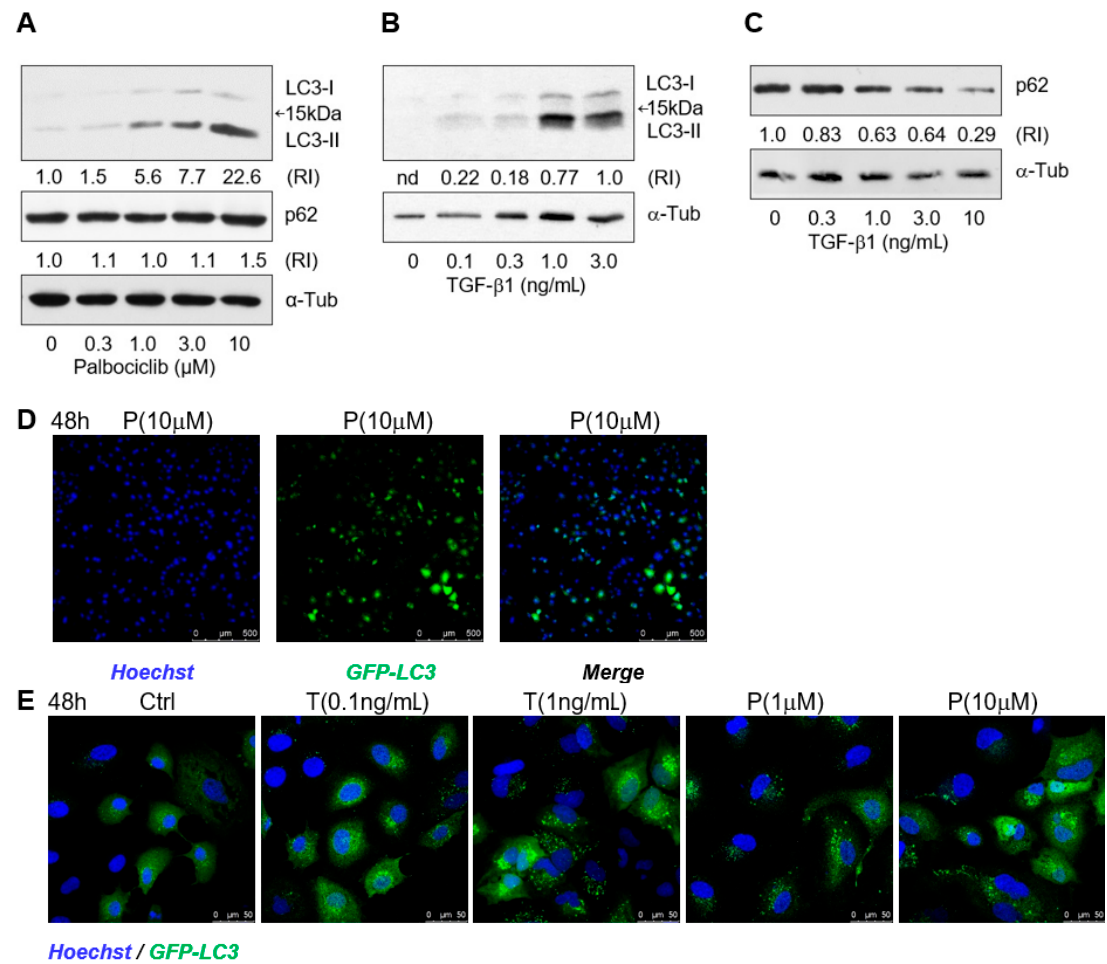
Figure 4. TGF- β 1 and palbociclib activate biogenesis of autophagosome in hepatoma cells. ( A ) Western blots for LC3-I, LC3-II, and p62 in Huh7-luc/neo cells treated with palbociclib for 72 h and ( B , C )with TGF- β 1 for 48 h; α -tubulin was used as a loading control. Protein content is expressed as the relative intensity of either the LC3-II or p62 band versus the α -tubulin band. ( D ) Assessment of percentage of Huh7 cells stably expressing GFP-LC3 after 48 h of treatment of cells with 10 μ M palbociclib (P). ( E ) Confocal microscope images of Huh7 cells stably expressing GFP-LC3 and treated with indicated concentrations of TGF- β 1 (T) and palbociclib (P) for 48 h.